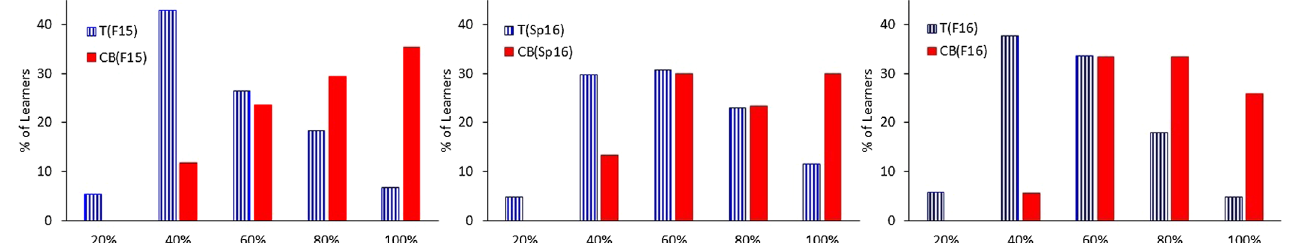
FIG. 5. Distribution of learners of the two classes (Tand CB) in terms of the post instructional FCI scores at the end of fall 2015 (left), spring 2016 (middle), and fall 2016 (right) semesters. The height of the vertical bars indicate the percent learner population that fell into each percentile group listed along the horizontal axis. The striped columns represent the T class and the solid columns represent the CB class. Unlike at the diagnostic survey (Fig. 3), the learners in the two classes demonstrate distinctly different distributions at the end of the learning process. In the T class, the learners are concentrated in the below 60% range and in the CB class the learners are populated in the above 60% range.